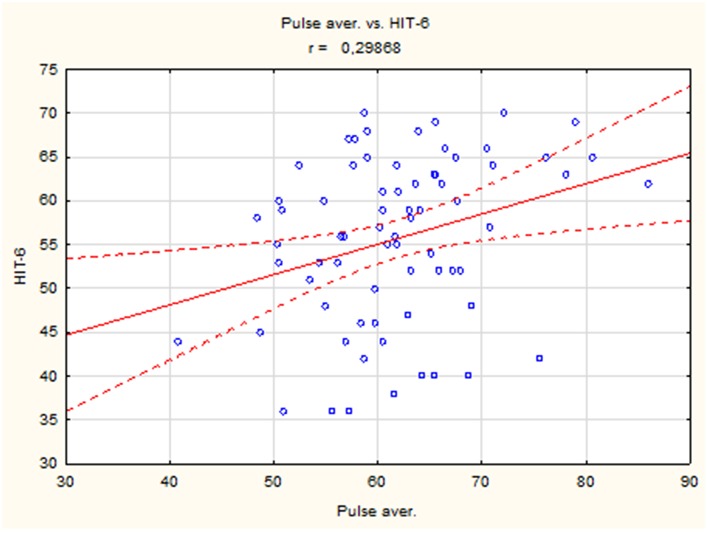
The correlation between mean heart rate and HIT-6 score in whole studied group.